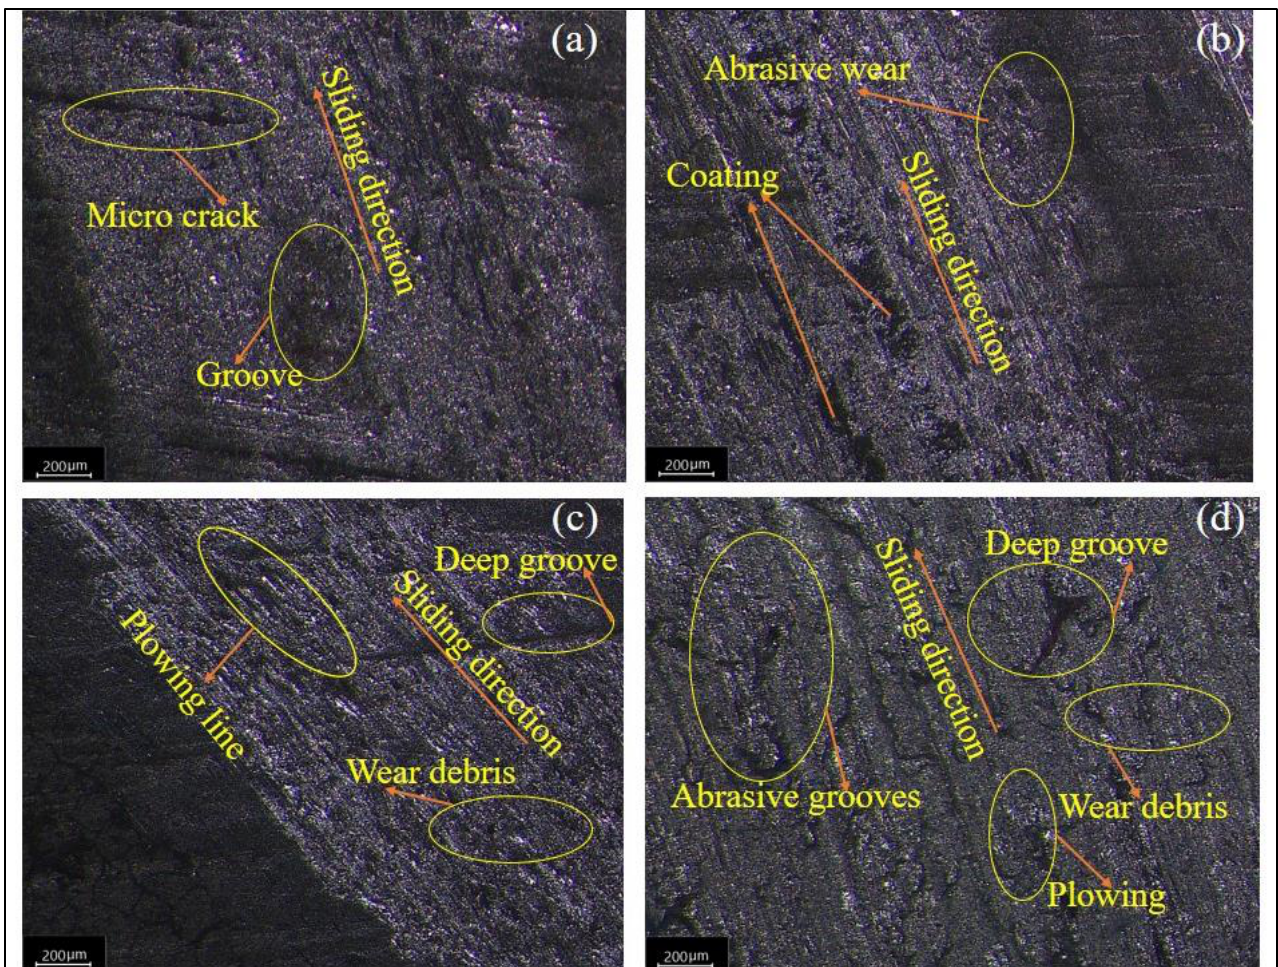
Figure 13. Micro-graphs of wear surfaces: ( a ) MoS 2 ; ( b ) 9 wt% g-C 3 N 4 /MoS 2 ; ( c ) 20 wt% g-C 3 N 4 /MoS 2 ; ( d ) uncoated steel substrate.